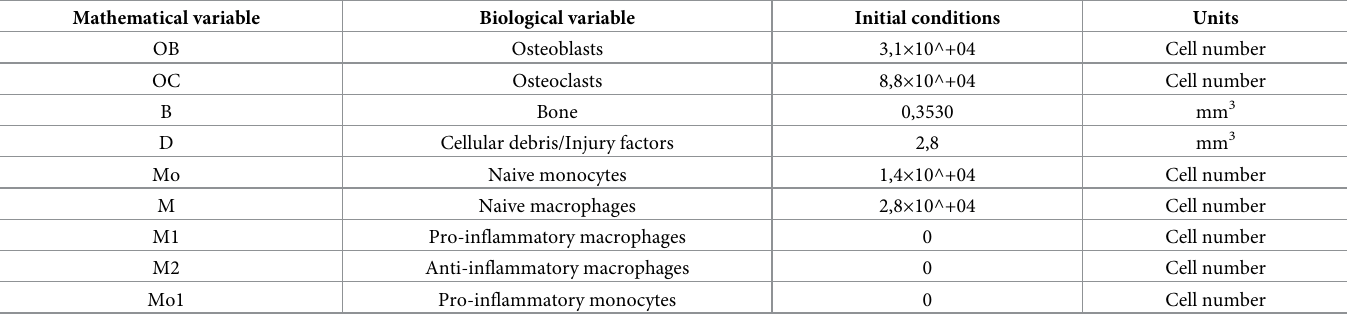
Table 5. Model variables description. Residuals lower than one for Mathematical model of all 18 combinations of hypotheses, resulting from J 2 and J 1 minimization. For each hypothesis combination, the table shows how many residuals are lesser than 1 over all 40 residuals, which equates how many times the model lies within the exper- imental error